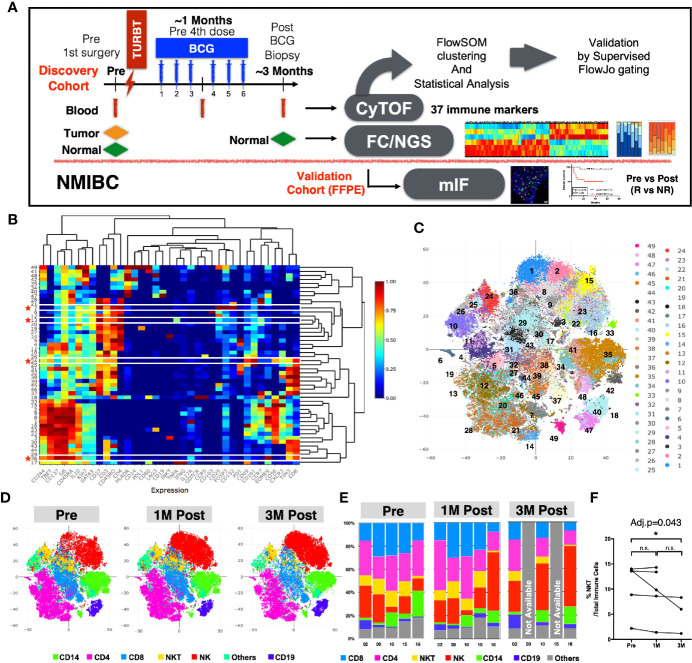
Immune profiles of peripheral blood mononuclear cells (PBMCs) before and after BCG treatment. (A) Schematic diagram of the experimental design and analysis workflow. (B) Heatmap depiction of 49 FlowSOM clusters with normalized protein expression (arcsine scaled) of all 37 markers from 13 PBMC samples. *denotes the four clusters significantly different among three time points by repeated measure ANOVA statistical test. (C) Visualization of 49 FlowSOM clusters in a t-SNE map, each clusters represented by different colors. (D) t-SNE maps showing major immune lineages, each indicated by one color, at Pre, 1M Post-BCG and 3M Post-BCG time points. (E) Bar charts for manually gated proportions of major immune lineages from PBMCs of five patients at Pre, 1M and 3M Post-BCG time points. (F) Line plot showing the frequencies of NKT cells over total immune cells at three time points from all patients. Connected line specifies samples from same patient at different time points. *adjusted p<0.05 with non-parametric One-way ANOVA by Friedman’s test followed by multiple pairwise comparison using Dunn’s test for matched data points with complete set of three time points. BCG, Bacillus Calmette-Guerin; TURBT, transurethral resection of bladder tumor; NMIBC, non muscle-invasive bladder carcinoma; NGS, next generation sequencing; FC, flow cytometry; mIF, multiplexed immunofluorescence imaging; R, Responders; NR, non-responders.